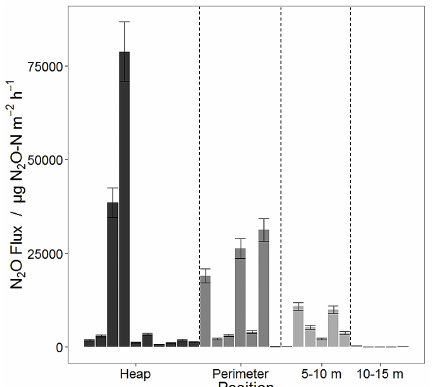
Figure 5. N 2 O flux measurements from a semi-permanent manure heap located on the grassland field. Vertical dashed lines split the measurements into groups separated by distance from the heap with the left side of the figure being the nearest and right side the furthest from heap. The darkest bars in the figure represent measurements made on top of the actual manure heap. Next are the measurements made from the base of the heap, then those made 5 to 10m and 10 to 15m from the